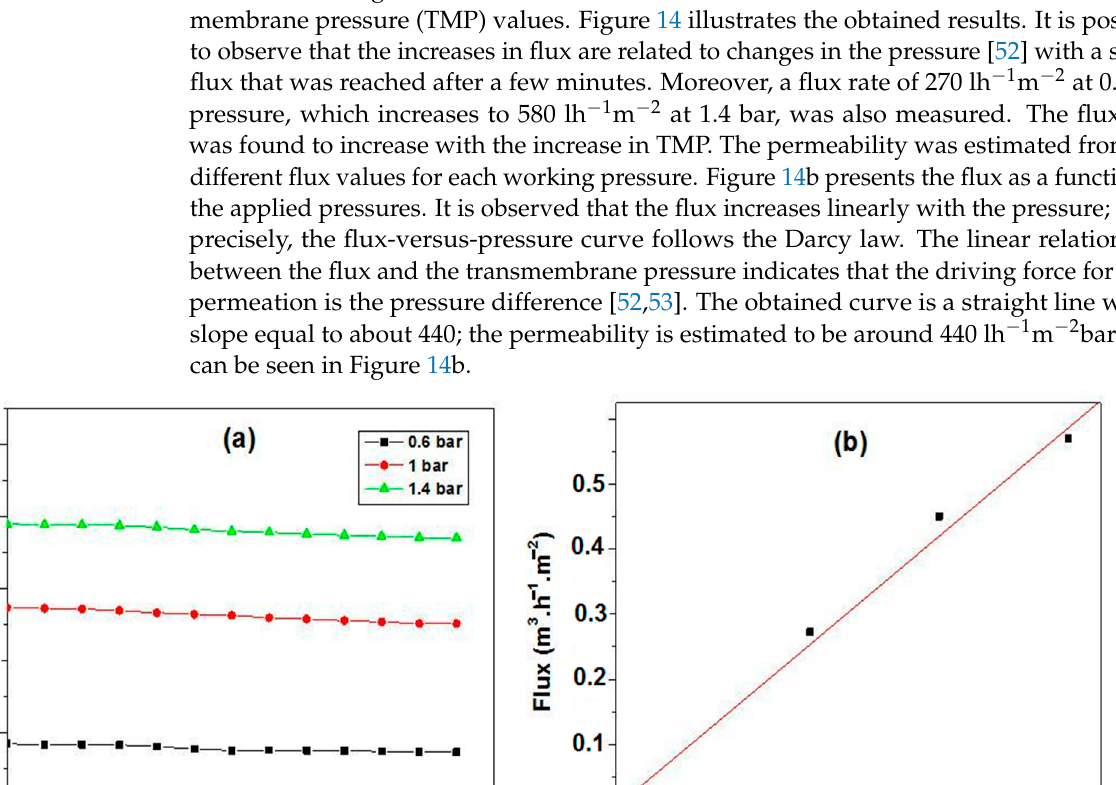
Figure 13. Figure 13. (A ) Isotherms from nitrogen sorption measurements for: (a) support (1250°), (b) support + interlayer, (c) support + interlayer + top layer. ( B ) Pore size distribution for multilayer system.